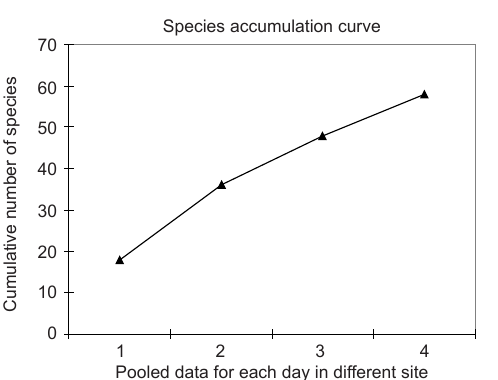
4 Pooled data for each day in different site Figure 1. Species accumulation curve of butterflies in the four sites (1388.5ha area) sampled (1.5h each) over four successive days (23-26 September 2008) in sal forest Figure 2. Relative species diversity, evenness, and habitats of Ankua Reserve Forest, Koina Range, Saranda richness of butterflies in the four sites sampled (1.5h each) Division, West Singhbhum District, in sal forest habitat of Ankua Reserve Forest Division, Koina Range, Saranda Division, West Singhbhum District, Jharkhand (23 -26 September 2008). Table 1. Similarity between four sites studied in terms of butterfly species composition (September 2008). Sites